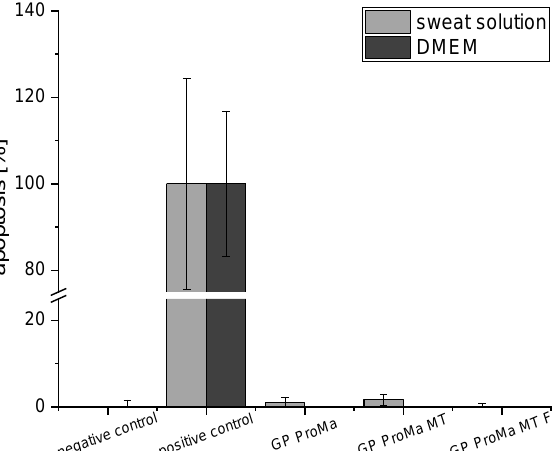
Figure 10. Apoptosis [%] of the HaCaT cells exposed to the sample extracts in DMEM and sweat solution for 24 h. For the positive control, actinomycin D was used.